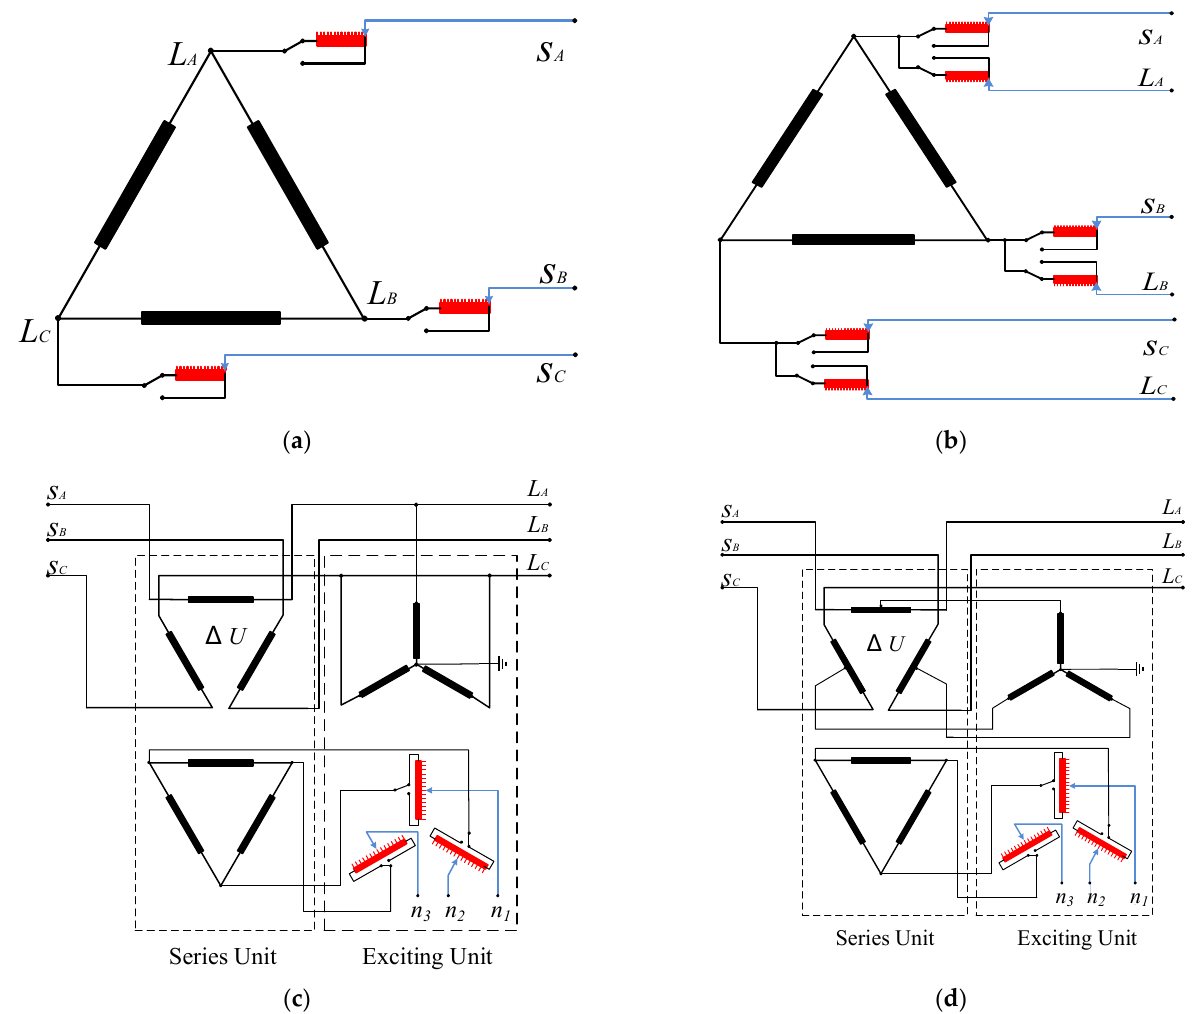
Figure 3. Various types of PST topology : ( a ) Single core asymmetric type, ( b ) Single core symmetrical type, ( c ) Two core asymmetric type, and ( d ) Double core symmetrical type.